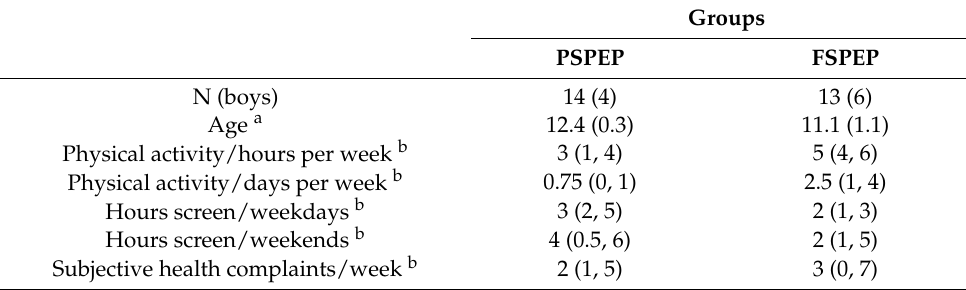
Table 1. Participant descriptive characteristics.